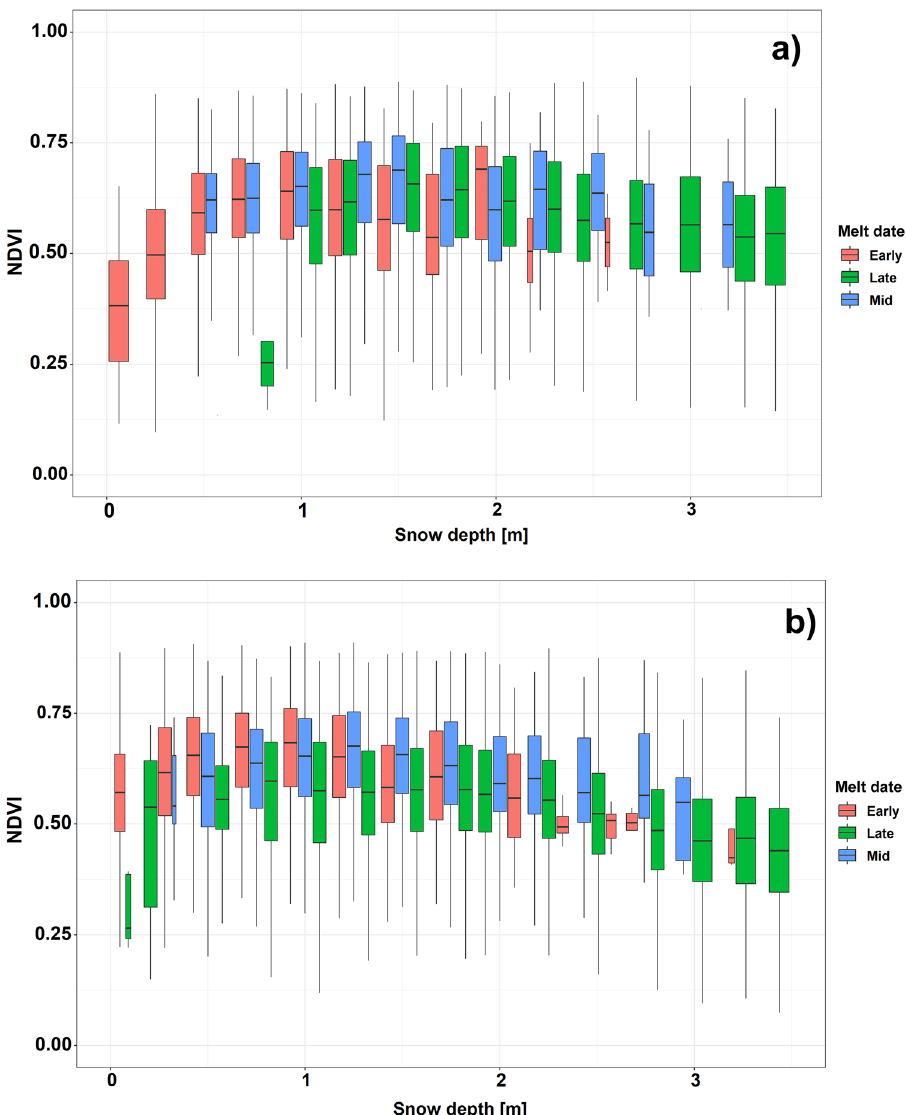
Figure 3. Box plots of maximum snow depth and maximum NDVI values observed in 2020 ( a ) and 2021 ( b ). Values have been categorized in the three main melt-out date groups (early melt, mid melt and late melt) and grouped by 0.25 m snow depth intervals. The boxes show first and third quantiles and the horizontal line inside each box the median. Whiskers of each plot include maximum and minimum values for each